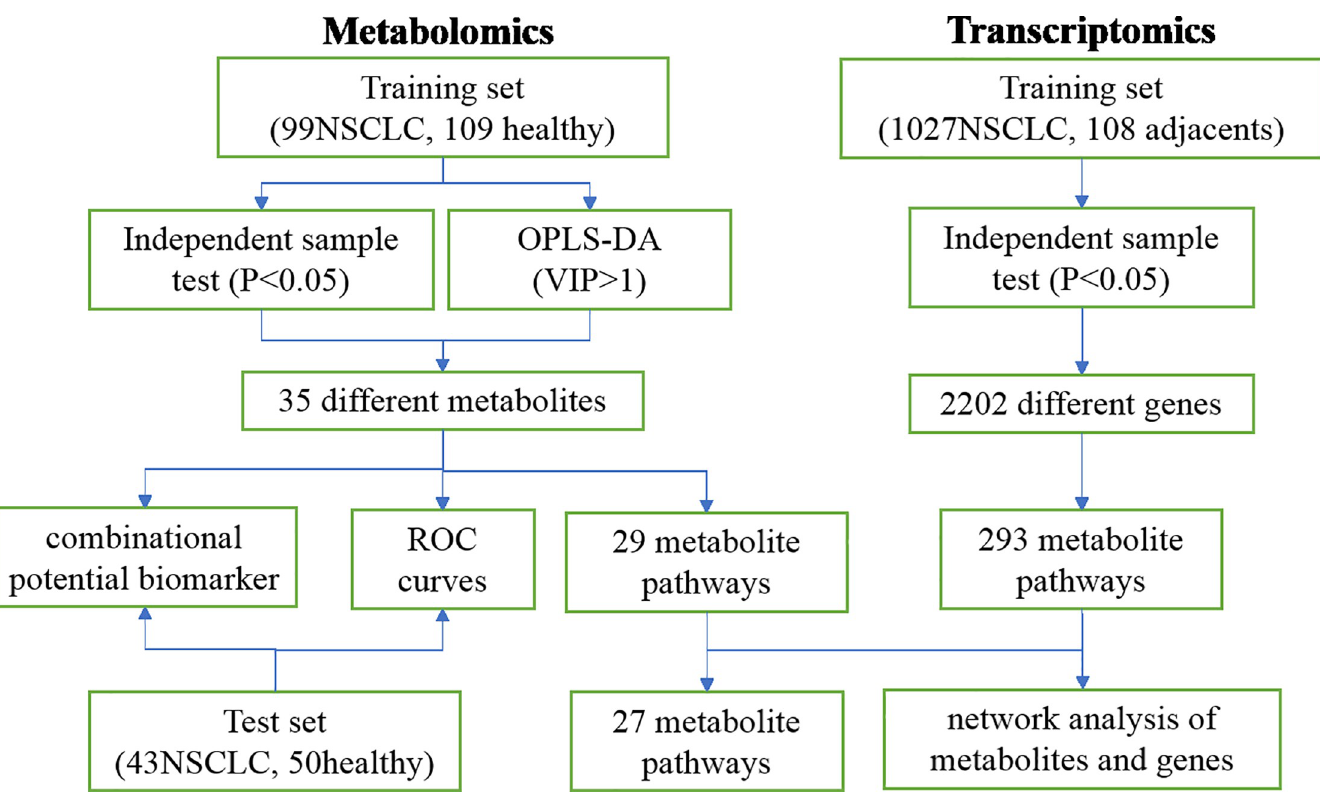
Fig 1. An overview workflow of the comprehensive analysis of metabolomics and transcriptomics in NSCLC.